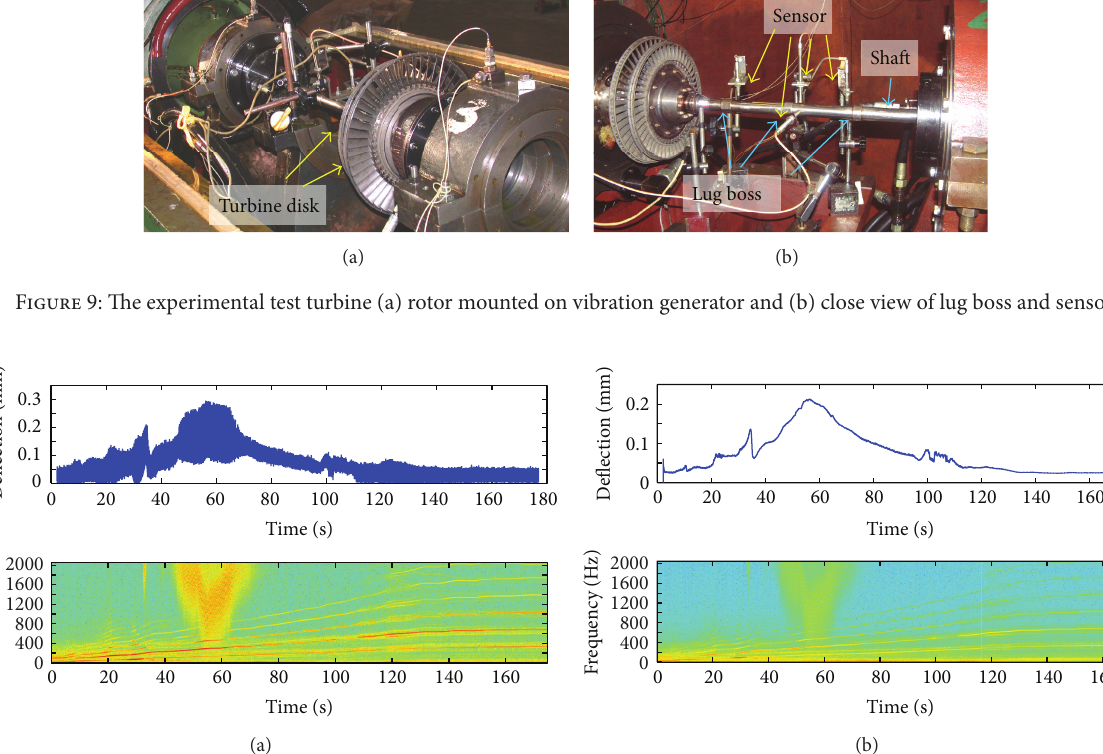
𝑒 𝑖 : Eccentricity ratio on the ̇𝜑 : Spin velocity M , C , K : Mass matrix, damping matrix, and stiffness matrix of the rotor,